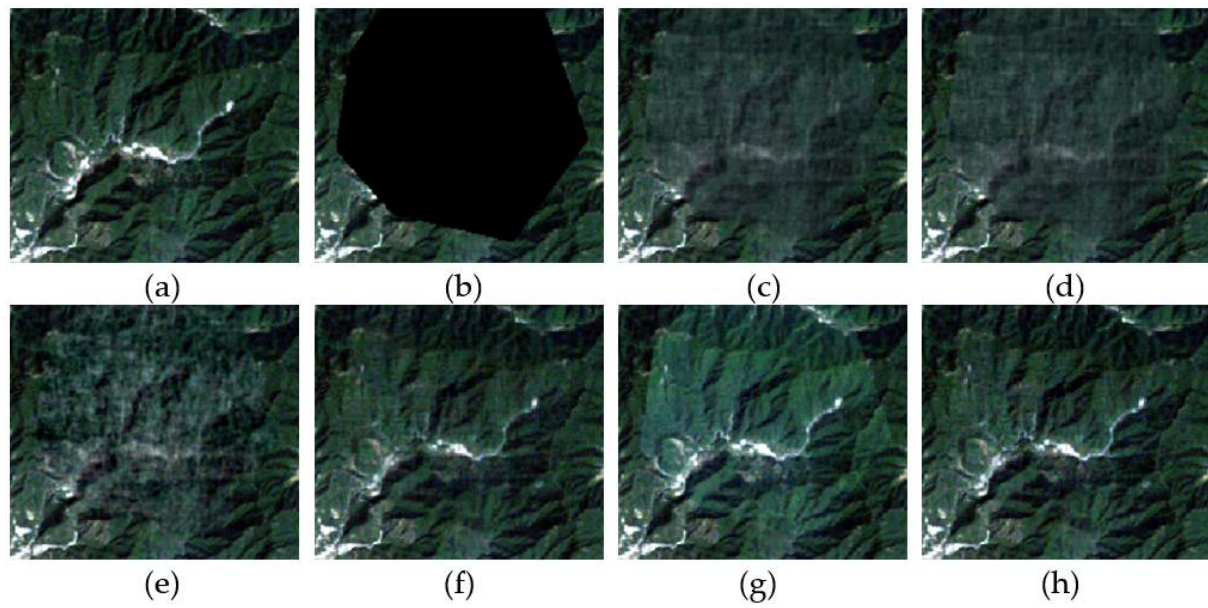
Figure 9. The simulated experiment performed on dataset 3: ( a ) original image; ( b ) simulated cloudy image; ( c – h ) reconstructed images of HaLRTC, AWTC, NL-LRTC, TVLRSD, ST-Tensor and FMTC algorithms, respectively.